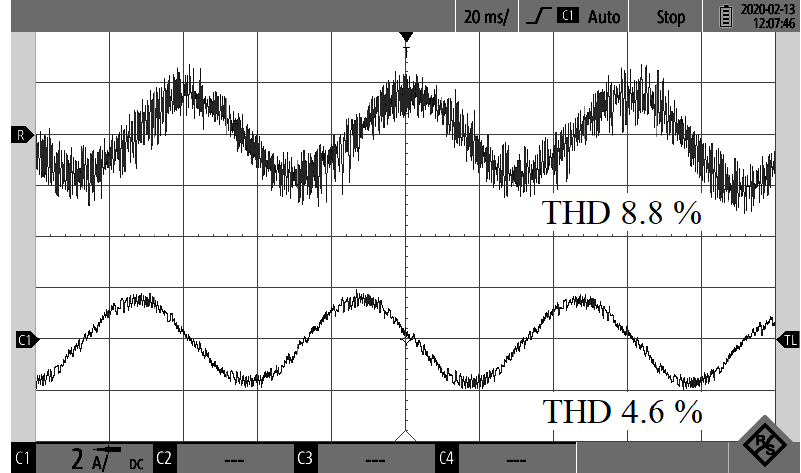
Figure 7. Phase current comparison. Reference speed 500 min − 1 ; reference flux: 1 Wb, no-load operation Top: 570 V DC-link voltage; bottom: 210 V DC-link voltage.